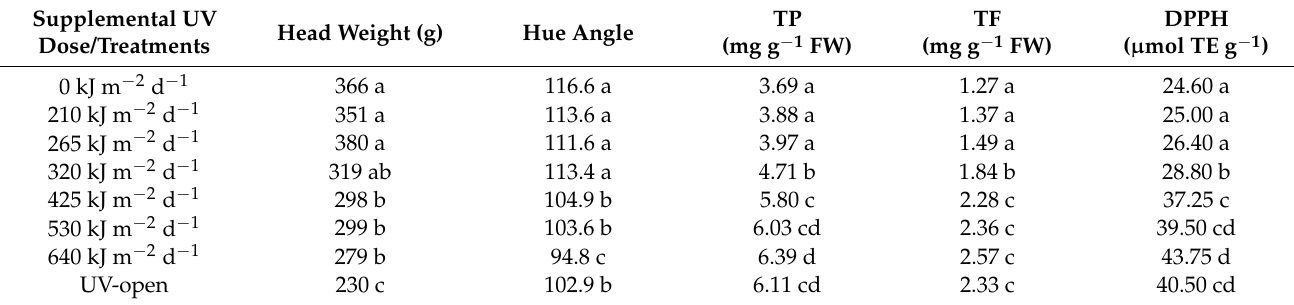
Table 7. Effects of 10-day pre-harvest supplemental UV lighting on red lettuce (Redino Lollo rosso) head weight, leaf colour (hue angle), total phenols (TP), total flavonoids (TF), and antioxidant capacity